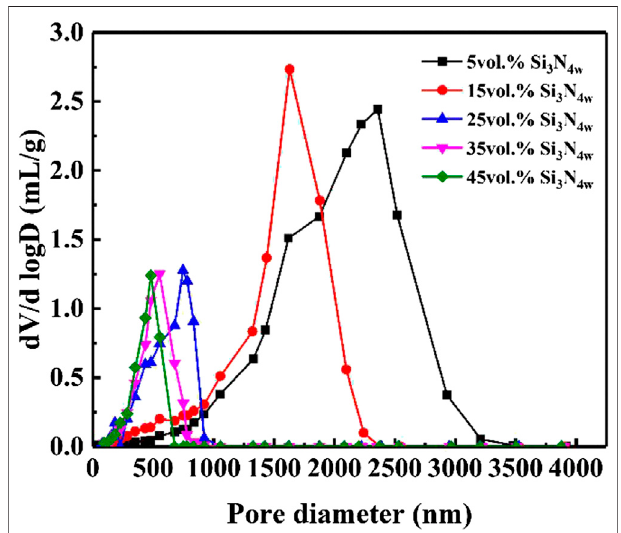
FIGURE 9 | Pore size distribution of Si 3 N 4w /Si 3 N 4 .